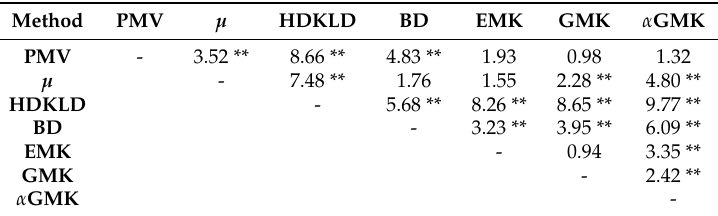
Figure 9. Boxplot of F1 score repartitions for the classification of the old and young grasslands. The line in the box stands for the median, whereas the dot stands for the mean. Table 5. Absolute value of Wilcoxon rank-sum test statistics on the F1 score for the old and young grasslands’ classification. ** indicates that the results are significantly different, i.e., p -value <